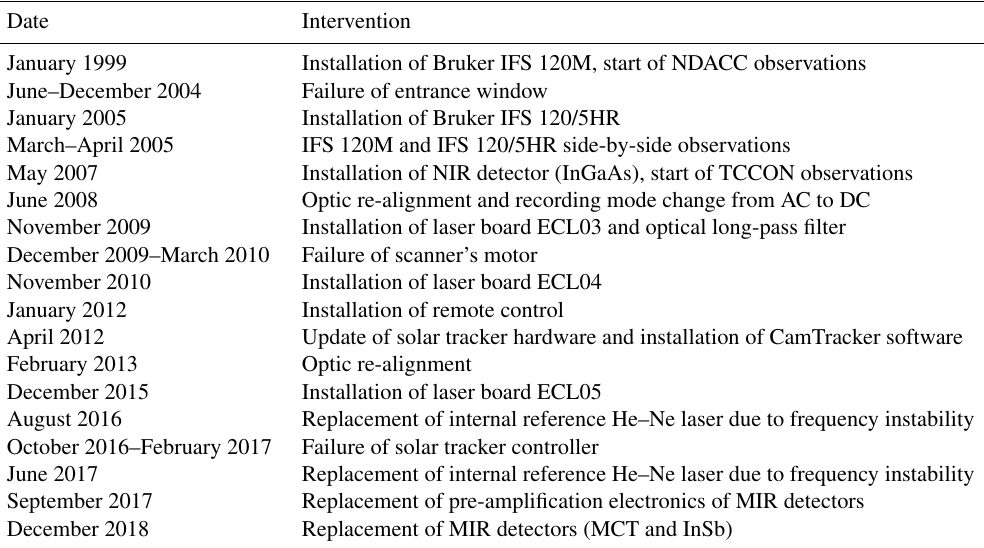
Table 1. History of the FTIR instruments at IZO with the most important interventions and data